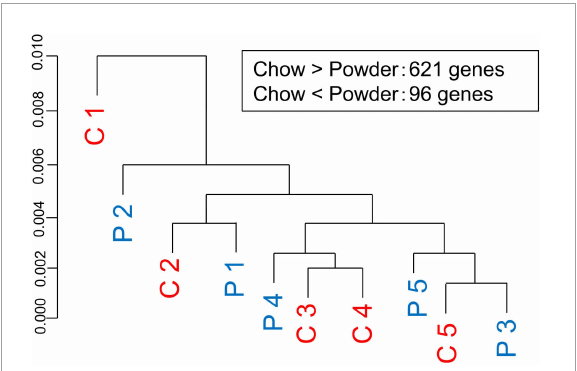
FIGURE5 Transcriptome analysis of the hippocampus. Hippocampal regions were manually dissected and subjected to transcriptome analysis using Rat Genome 230 2.0 Array chip. C-group (C 1 to 5) and P-group (P 1 to 5) did not show clear segregation in terms of overall gene expression (cluster dendrogram). Numbers of differentially expressed genes were indicated as an